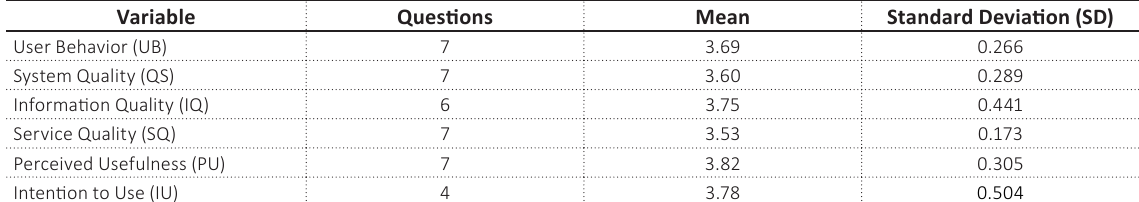
Table 3. Descriptive statistics